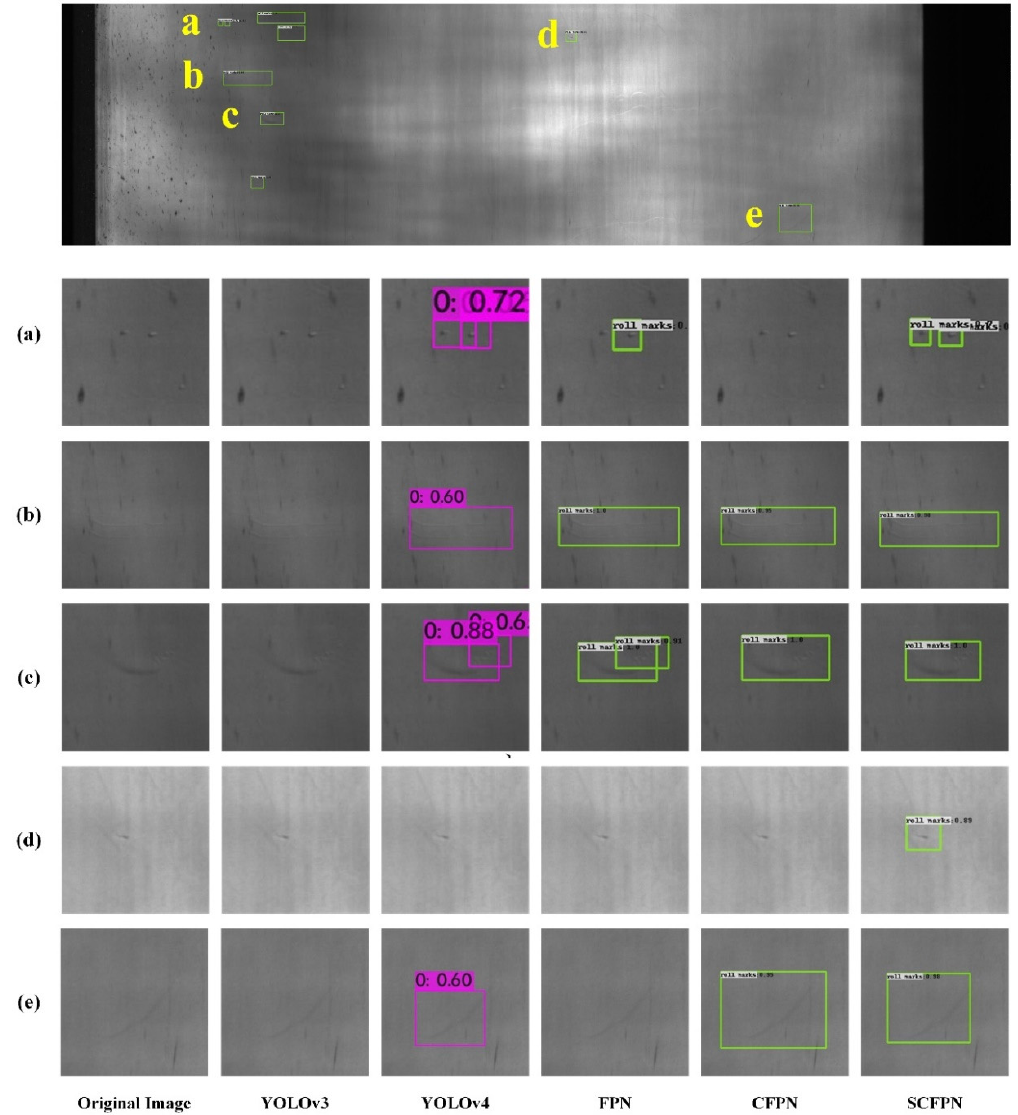
Figure 8. Visual detection results of different detection networks on CSU_STEEL. ( a ) tiny round roll marks; ( b ) long and narrow roll marks; ( c ) irregular roll marks with discontinuous shape; ( d ) concave roll marks with tiny line shape; ( e ) blurry and inclined roll marks